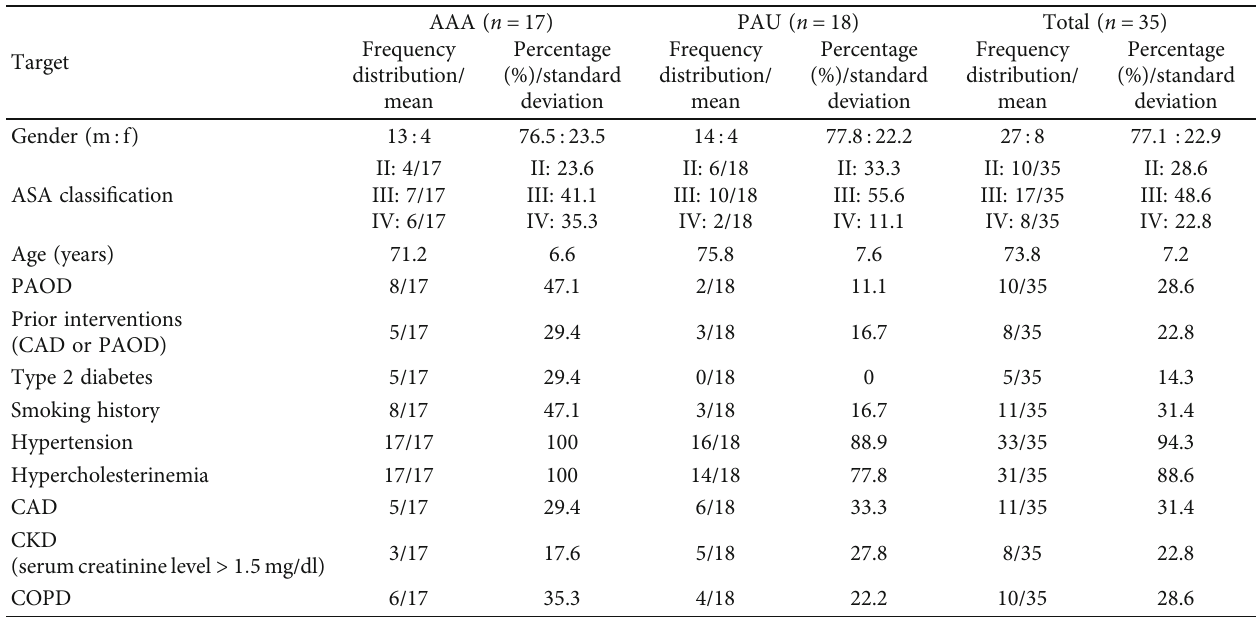
m=male; f= female; ASA= American Society of Anesthesiologists; PAOD=peripheral artery occlusive disease; CAD= coronary artery disease; COPD= chronic obstructive pulmonary disease; CKD= chronic kidney disease; mg/dl= milligrams per deciliter; n =